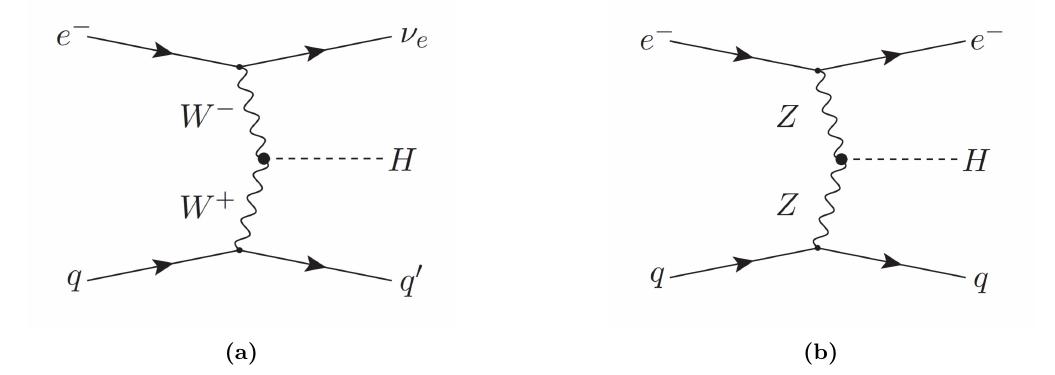
Figure 1 . Leading order Feynman diagrams for single Higgs production at e − p collider. ( a ) Charged-current process. ( b ) Neutral-current process.